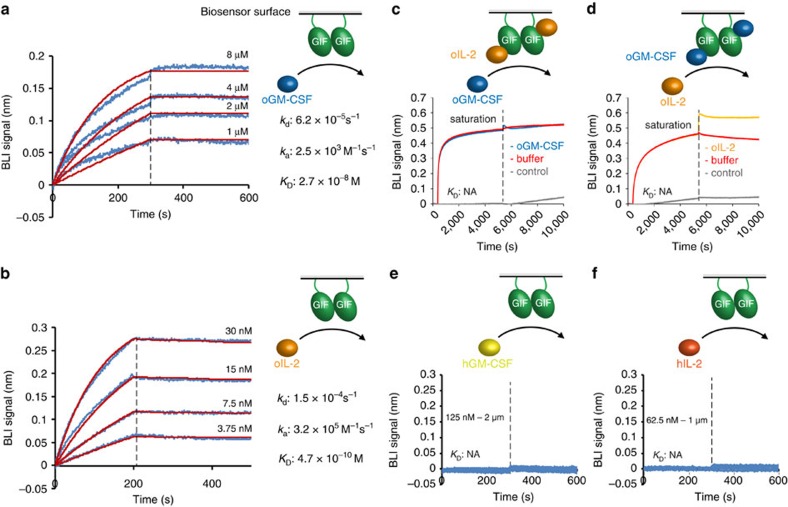
GIF binds GM-CSF and IL-2 with high affinity and distinct binding kinetic profiles.(a,b) Kinetic profiles of GIF:GM-CSF and GIF:IL-2 interactions characterized by BLI. In each case, biotinylated GIF was coupled to the surface of streptavidin coated BLI sensors, followed by binding measurements in different concentrations of GM-CSF/IL-2. Binding data was fitted using a 1:1 interaction model. (c,d) BLI measurements of the binding affinity of GM-CSF and IL-2 after saturating GIF bound sensors with IL-2 or GM-CSF respectively. After saturation with GM-CSF/IL-2, binding to the other cytokine is completely abolished (KD: NA=not applicable). (e,f) BLI measurements demonstrate that GIF does not bind to human orthologues of GM-CSF and IL-2. Displayed KD, kd and ka values represent the average of three replicate experiments. Errors on the average KD, kd and ka values can be found in Supplementary Table 5.